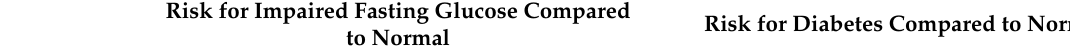
Table 4 shows the results of the multivariate logistic regression analysis of the maternal risk of impaired fasting blood glucose and diabetes according to the duration of breastfeed- ing, with adjustment for significant variables. It was identified that the risk of diabetes was decreased when breastfeeding was carried out for a period of 13 to 36 months. In the